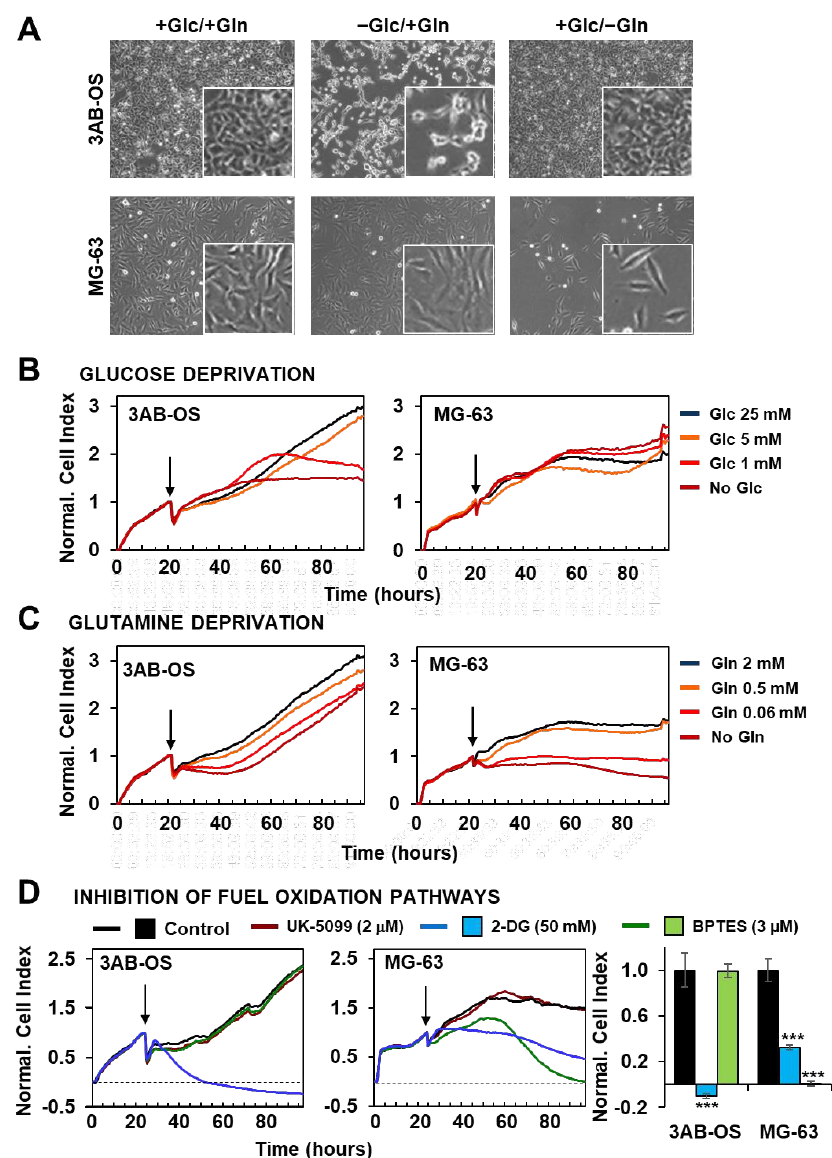
Figure 3. Effects of nutrient availability and metabolic pathway inhibition on osteosarcoma cell proliferation. ( A ) Phase-contrast images of 3AB-OS (upper panel) and MG-63 (lower panel) cultured for 48 h in three different conditions (from the left to the right): +Glc/+Gln, complete DMEM medium containing 25 mM glucose (Glc) and 2 mM glutamine (Gln); +Glc/ − Gln, DMEM medium with 25 mM Glc, without Gln; − Glc/+Gln, DMEM medium with 2 mM Gln, without Glc. ( B , C ) Representative normalized cell index kinetics of 3AB-OS and MG-63 cells exposed to stepwise decrease in Glc or Gln concentration. Cells were grown in complete DMEM medium for approximately 24 h after seeding. Then medium was changed, and cells were treated for 72 h with DMEM medium containing different concentrations of Glc ( B ) or Gln ( C ) as indicated by the arrows. Each cell index value was normalized just before this starting point. ( D ) Normalized Cell Index traces of osteosarcoma cell lines incubated with either the glycolytic inhibitor 2-DG (50 mM) or the GLS1 inhibitor BPTES (2 µ M) or the mitochondrial pyruvate carrier UK-5099 (2 µ M) for 72 h. Cells were grown in complete DMEM medium and the day after treated with antimetabolites. The histogram (last graph on the right) displays different sensitivity to 2-DG or BPTES of 3AB-OS and MG-63 cells. NCI values have been normalized to the relevant control. Data are presented as mean ± SD; n = 3. Statistical significances are referred to control. *** p < 0.0001. Abbreviations: 2-DG , 2-deoxy-D-glucose; BPTES , N,N (cid:48) -[thiobis (2,1-ethanediyl-1,3,4-thiadiazole-5,2-diyl)] bis